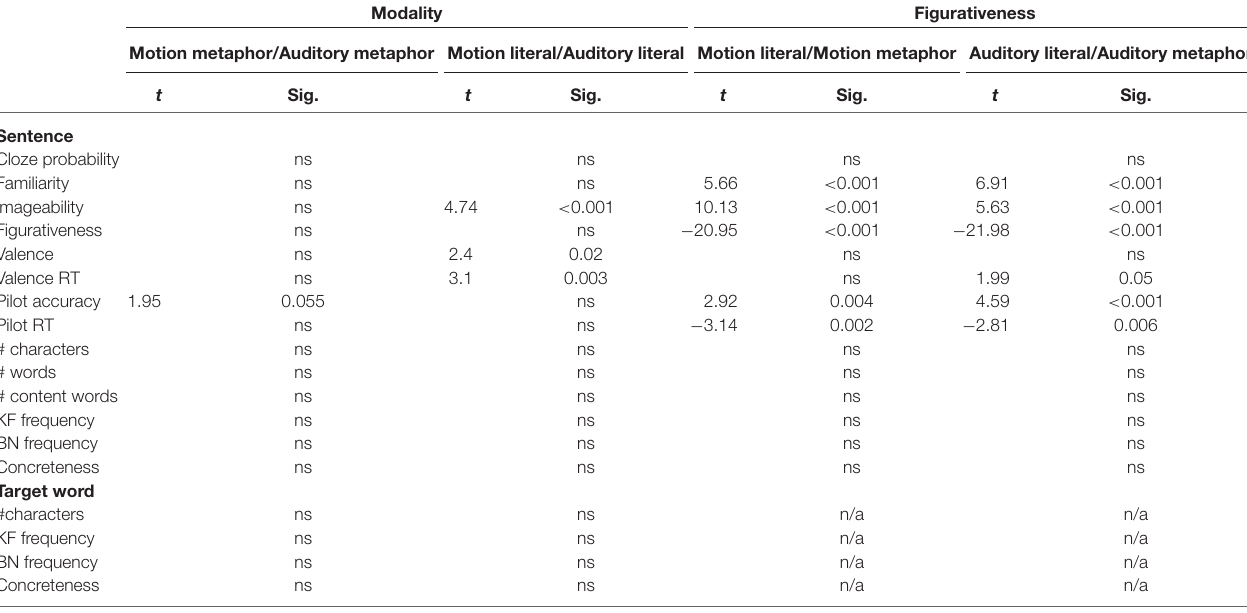
TABLE 3 | Comparison of final stimuli across modality and figurativeness conditions . Modality